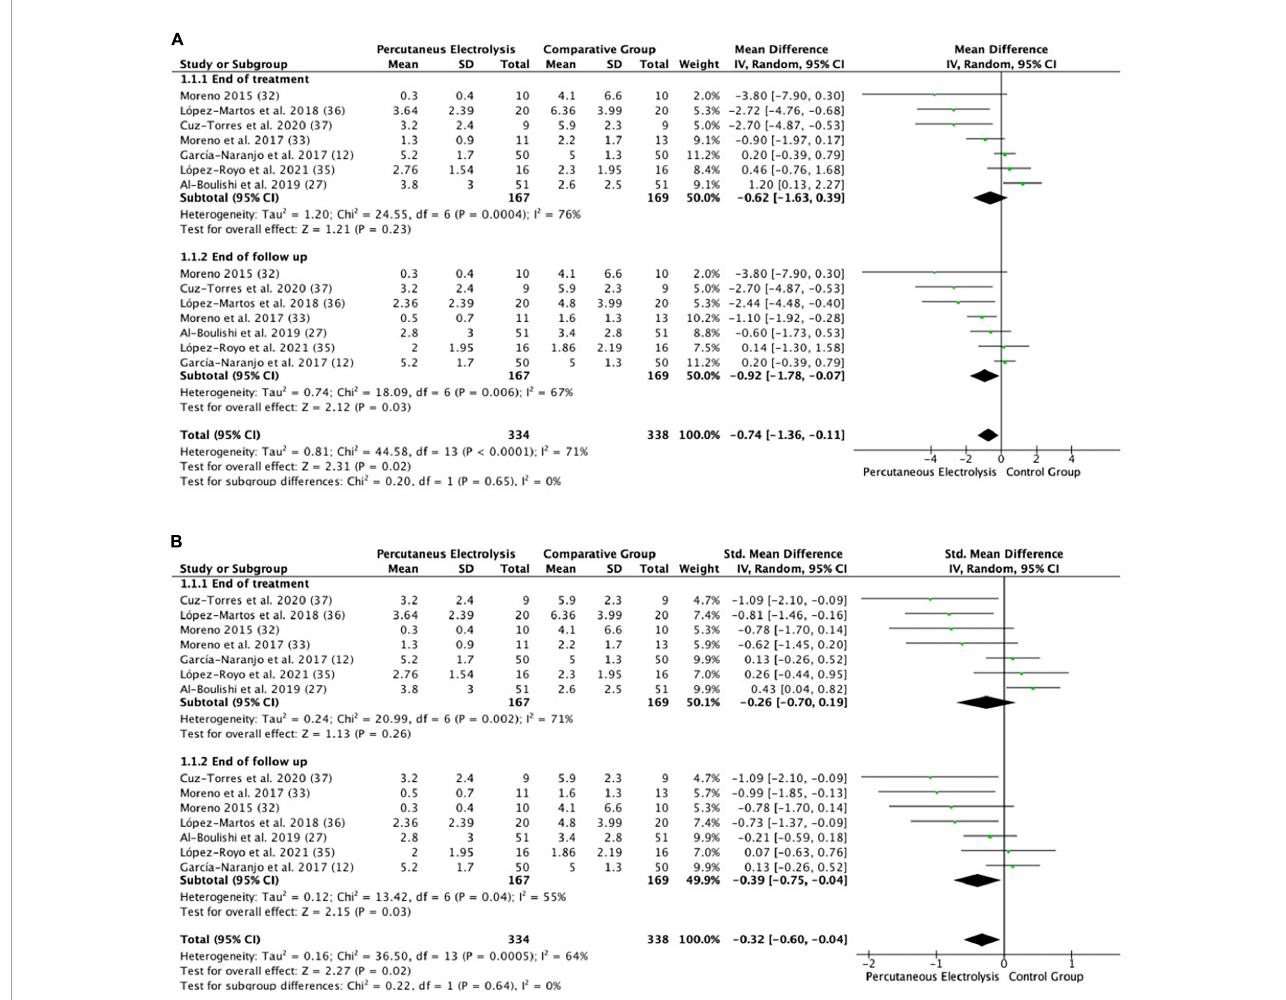
FIGURE4 Forest plot of the results of a random-effects meta-analysis shown as (A) mean differences (MD) and (B) SMD, with 95% confidence interval (CI) for the comparison of mean pain in the high intensity PE group and the control group. Short-term and long-term subgroups are reflected, depending on the time of the pain assessment. The shaded square represents the point estimate for each individual study and the weight of the study in the meta-analysis. The diamond represents the overall mean difference of the